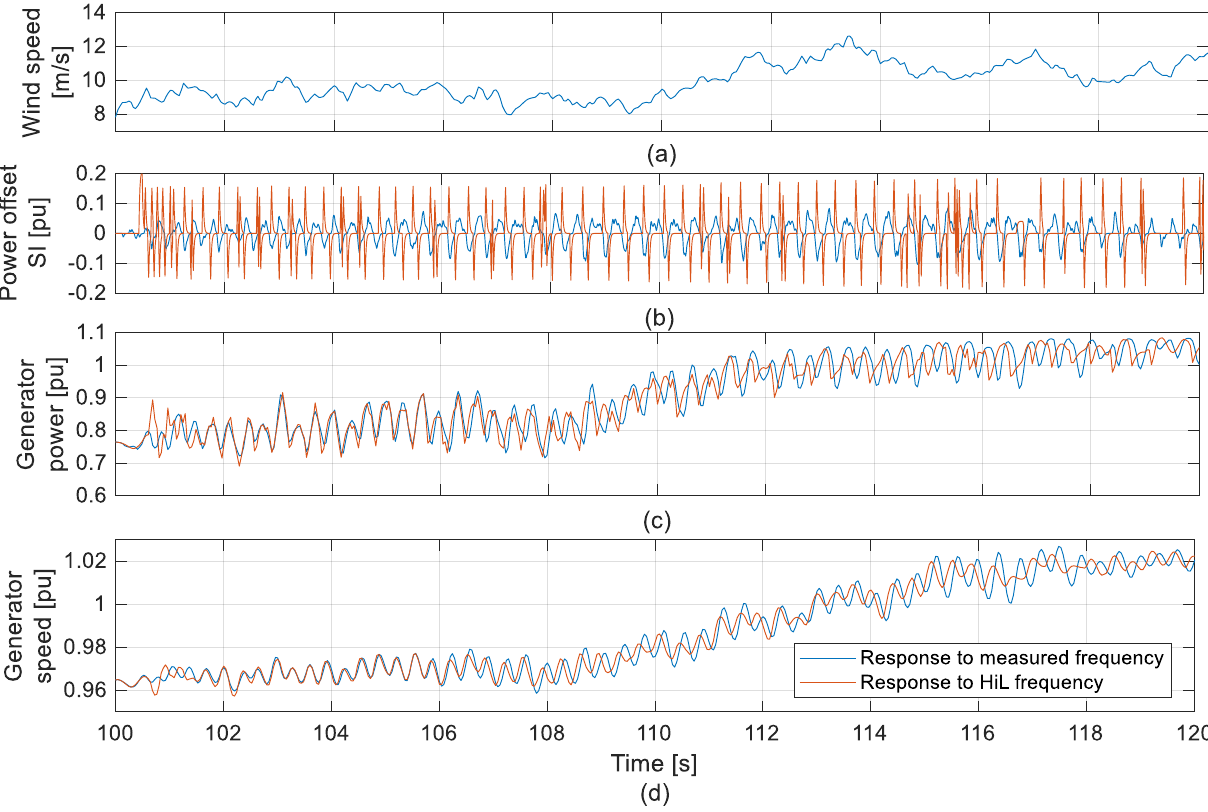
Figure 11. WTG reaction to scenario 2 for the measured frequency (blue) and the HiL frequency. ( a ) Wind speed, ( b ) power offset for SI provision, ( c ) generator power and ( d ) generator speed. Time axis of ( d ) is valid for the above subplots as well.